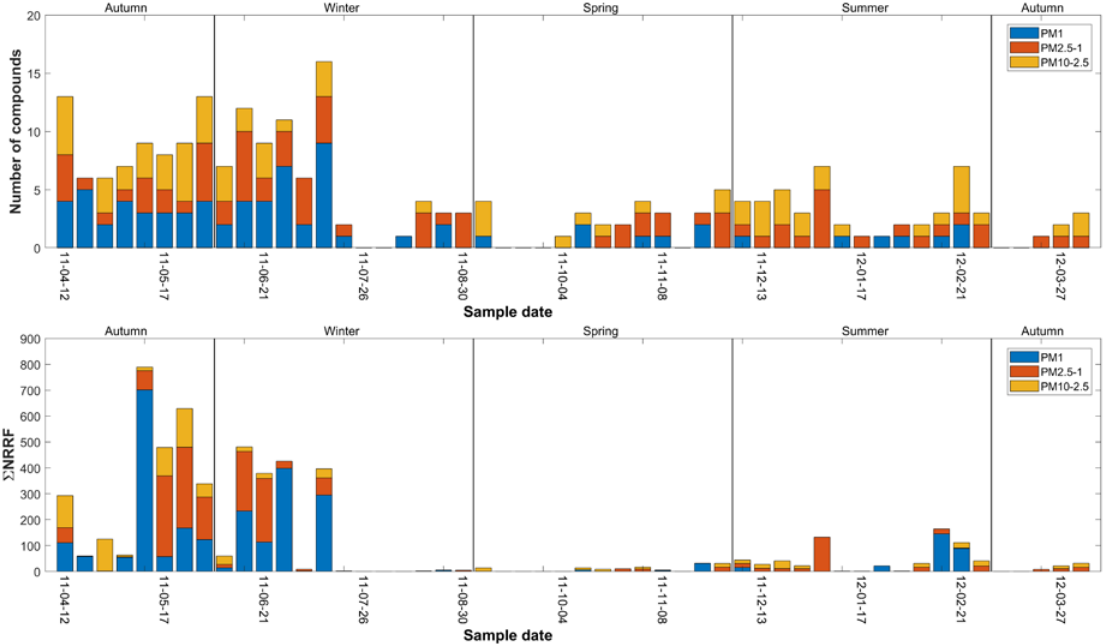
Figure 2. Total number of amines identified and their corresponding semi-quantified concentrations ( Σ NRRFs) in the three particle size fractions for each sample collected.